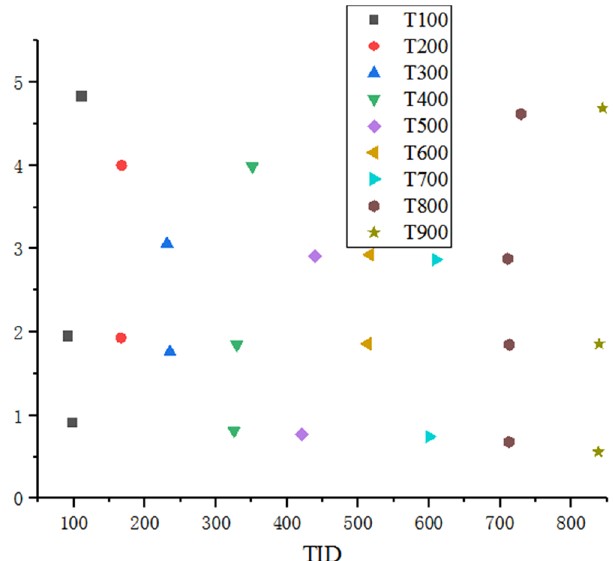
Figure 1: Set of related